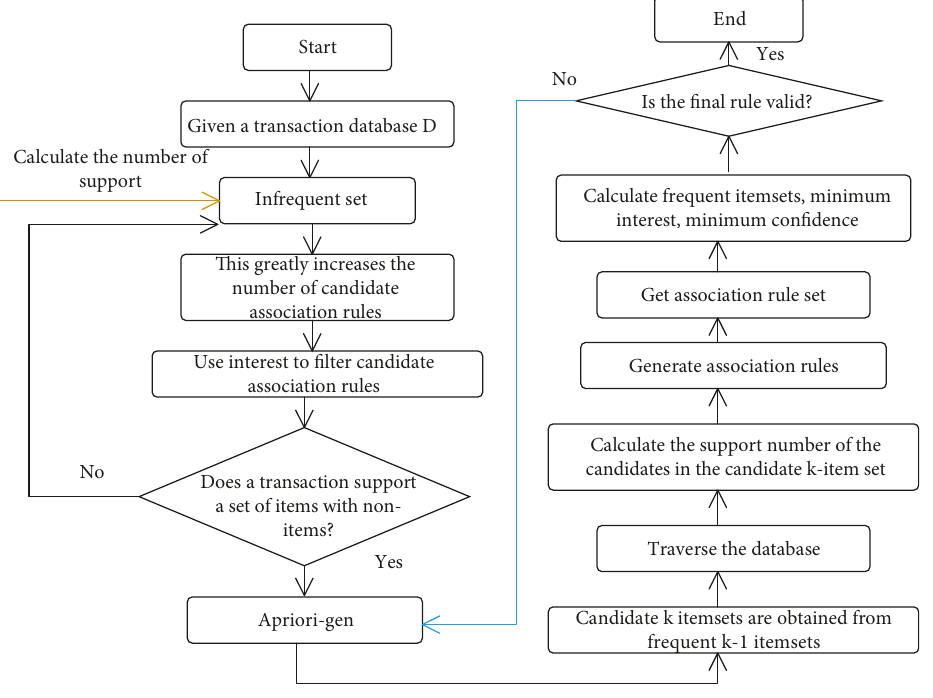
Figure 3: The flowchart of the improved Apriori